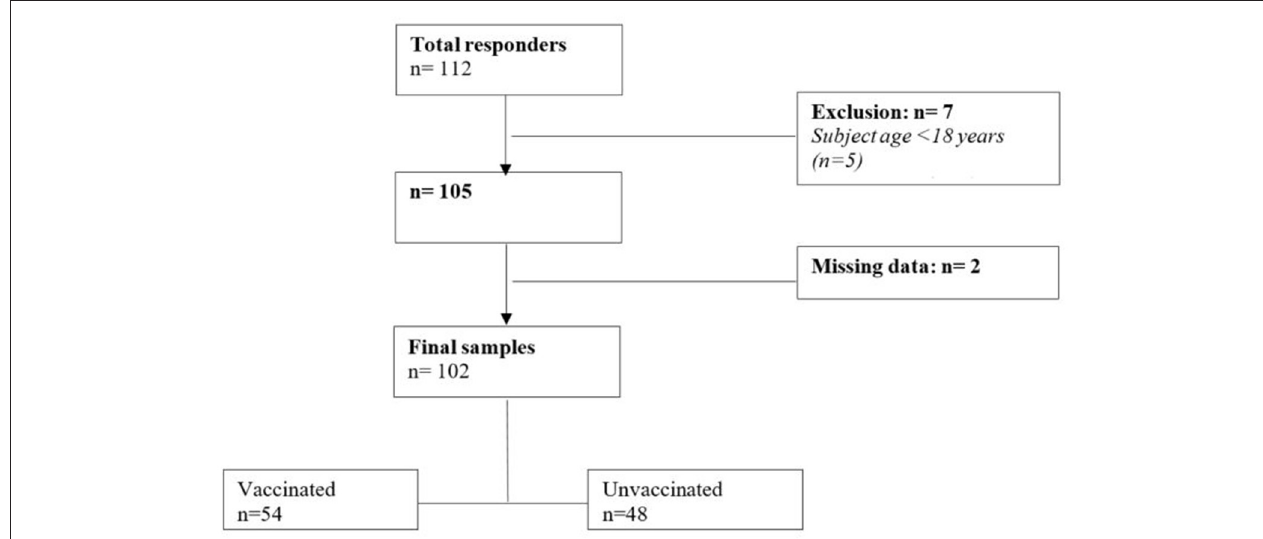
FIGURE 1 | Study design